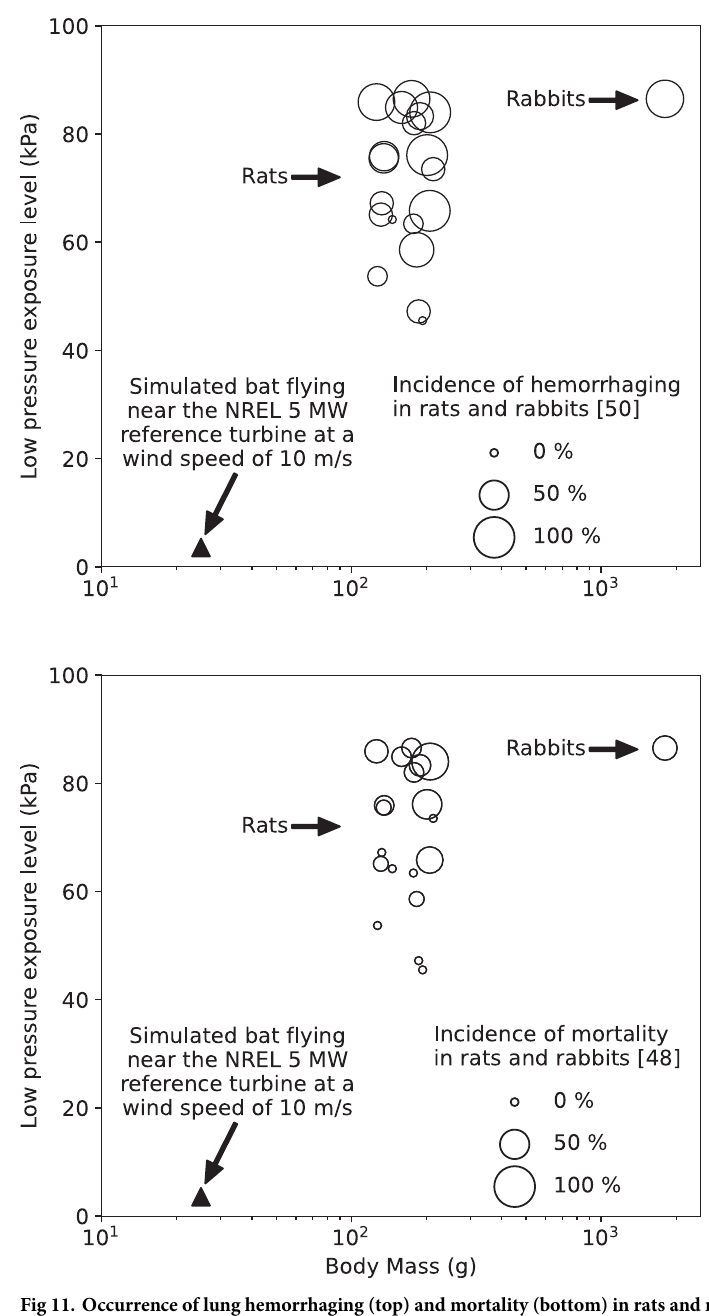
Fig 11. Occurrence of lung hemorrhaging (top) and mortality (bottom) in rats and rabbits as a result of sudden exposure to low pressures. The circles present the data from Junkui et al. [50] for rats and rabbits. The triangle indicates the largest magnitude low pressure our results indicate bats could be exposed to when flying near the NREL 5 MW wind turbine when the wind speed is 10 m/s. Note that there is no mortality or hemorrhaging data available for bats rapidly exposed to low